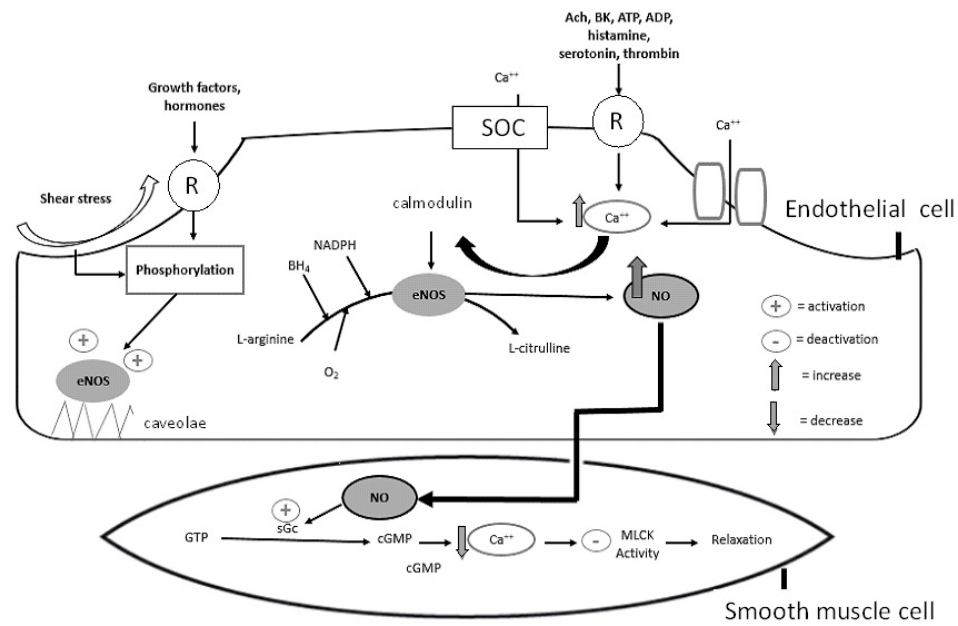
Figure 1. Synthesis of nitric oxide (NO) by endothelial cells. NO is released by the action of endothelial NO synthase (eNOS) on its substrate, L-arginine. For this reaction, several cofactors, such as tetrahydrobiopterin (BH 4 ), oxygen (O 2 ), and nicotinamide adenine dinucleotide phosphate (NADPH) are required. eNOS is activated by calcium-dependent and -independent pathways. Intracellular Ca is increased as a response to the function of NO agonists (including acetylcholine (Ach), bradykinin (BK), adenosine triphosphate (ATP), and adenosine diphosphate (ADP), serotonin, thrombin, and histamine) or by influx into the endothelial cell following the opening of the store-operated calcium channel (SOC) and other calcium permeable channels in the plasma membrane. Ca binds to calmodulin, and this complex dissociates eNOS from the inhibitor caveolin-1, located in the caveolae. eNOS can also be activated by the calcium-independent pathway of post-translational phosphorylation, which is triggered as a response to shear stress and the function of growth factors and hormones. After NO is generated, it diffuses across the membrane of smooth muscle cells and activates the guanylyl cyclase (sGC), which catalyzes the reaction from guanosine triphosphate (GTP) to cyclic guanosine monophosphate cyclic guanosine monophosphate (cGMP). The effect of this reaction is the transportation of calcium out of the cell, which downregulates the activity of myosin light chain kinase (MLCK), causing relaxation of the vascular smooth muscle cell. Abbreviations: Ach, acetylcholine; ADP, adenosine diphosphate; ATP, adenosine triphosphate; BH 4 , tetrahydrobiopterin; BK, bradykinin; Ca, calcium; cGMP, cyclic guanosine monophosphate; eNOS, endothelial NO synthase; GTP, guanosine triphosphate; MLCK, myosin light chain kinase; NADPH, nicotinamide adenine dinucleotide phosphate; NO, nitric oxide; O2, oxygen; R, receptor; sGC, guanylyl cyclase; SOC, the store-operated calcium channel.